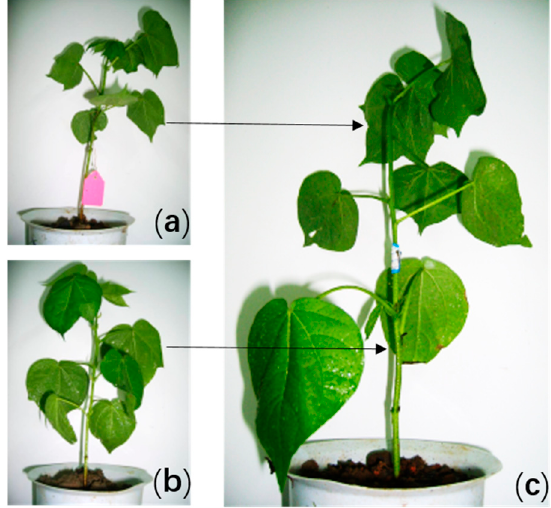
Figure 1. Testing materials. ( a ) The scion seedling of G. hirsutum cv. ‘Kangdi 99F 1 ′ ; ( b ) The rootstock seedling of perennial Gossypium barbadense var. ‘arboreal cotton 113 ′ ; ( c ) The grafted seedling of Kangdi 99F 1 /arboreal cotton 113. Table 1. Two groups of stem bark samples and their serial